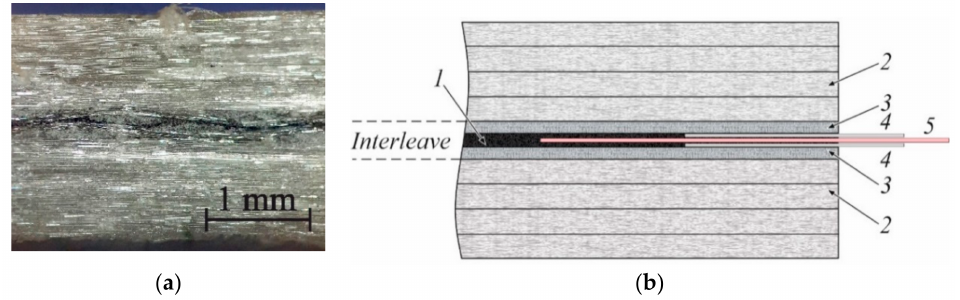
Figure 19. Eight-layered UD GFRP composite plate with the interleave. Micro photo of the longitudi- nal cross-section with magnification 200 × ( a ) and the laminate structure ( b ). The spray-coated